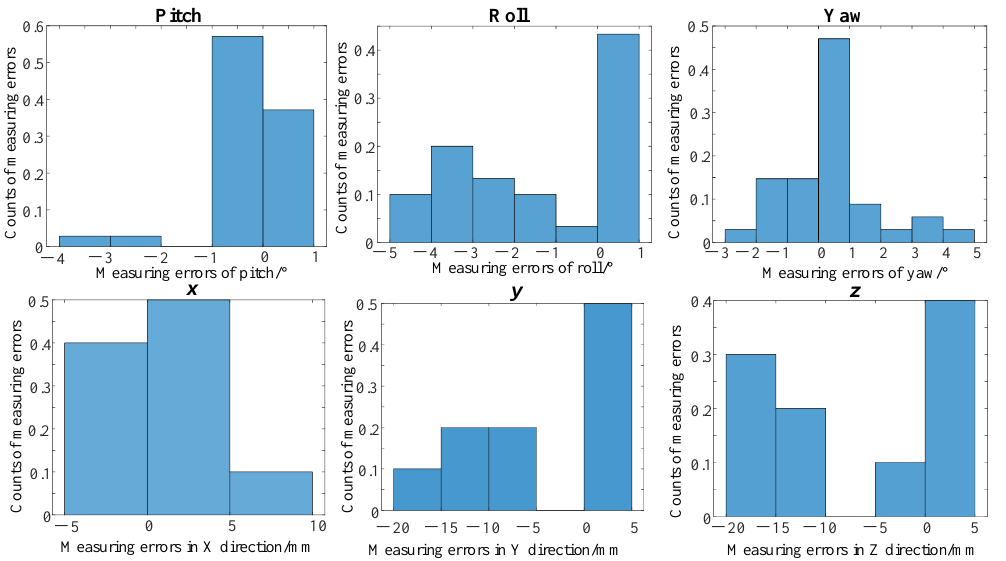
Figure 11. Non-cooperative target poses solution results.